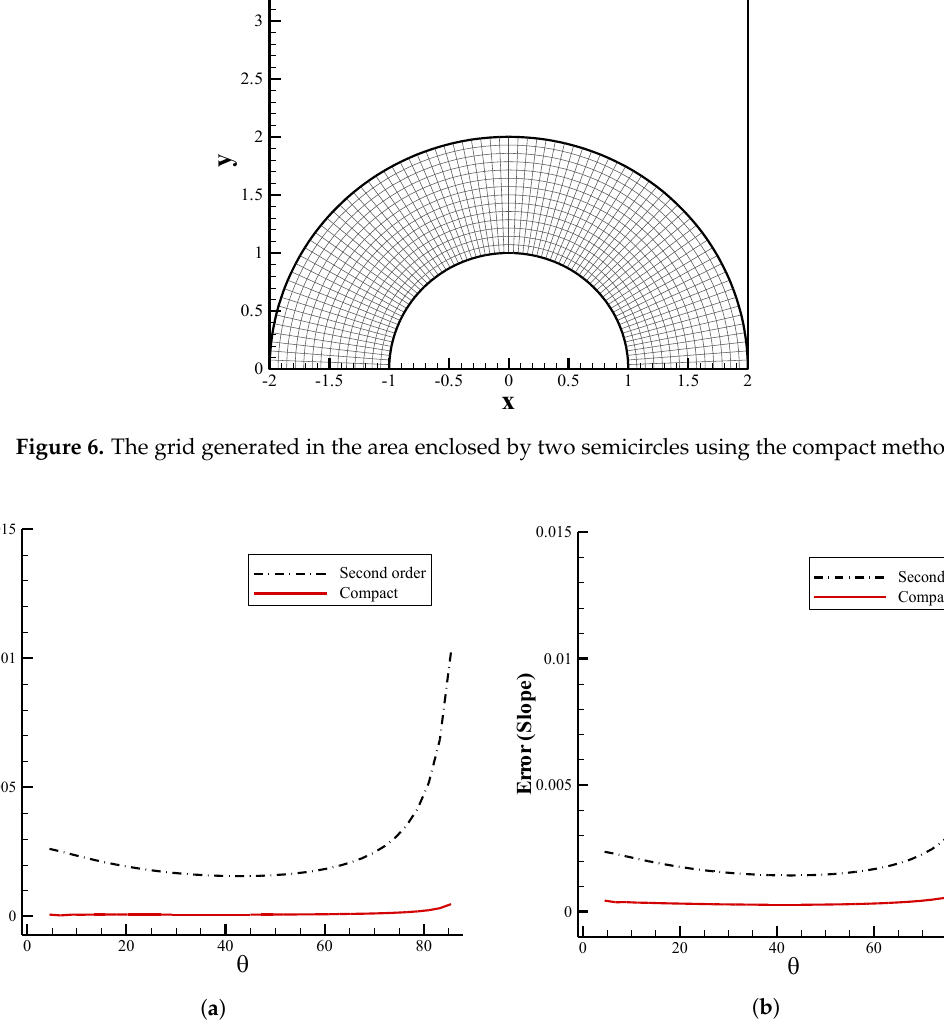
Figure 7. A comparison between the slope of the coordinate lines generated using the standard second-order and fourth-order compact methods and the orthogonal lines of the polar coordinate near the ( a ) lower and ( b ) upper boundaries of two